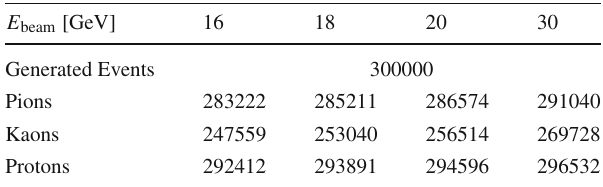
Table 4 Numbers of simulated (generated events) and retained pion, kaon and proton events for each beam energy value. Selection criteria used in the analysis are discussed in Sect.